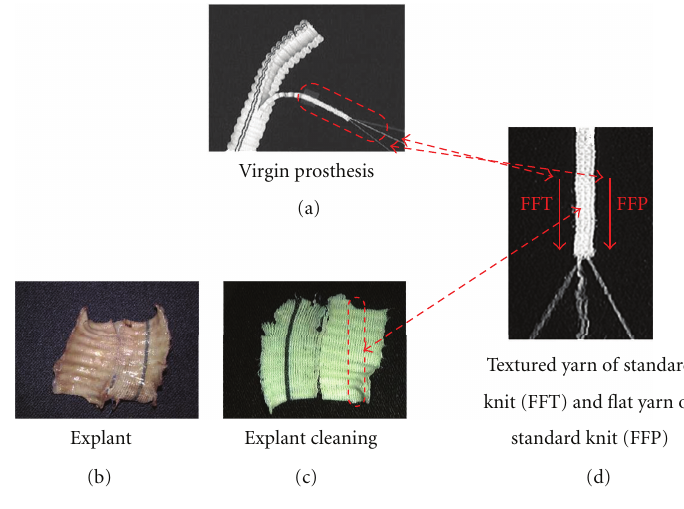
Figure 3: Sample